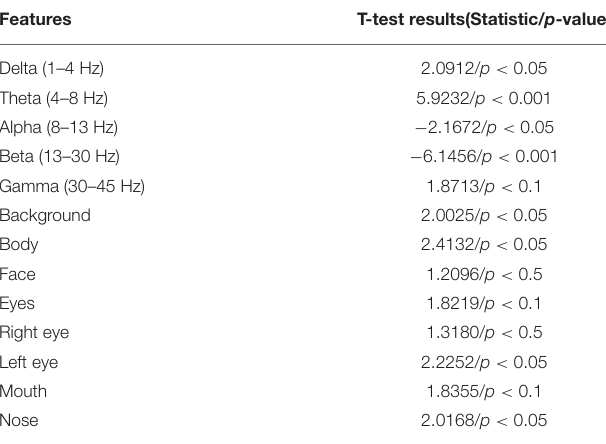
TABLE 3 | T-tests t-statistic values and corresponding p -value each feature. Features